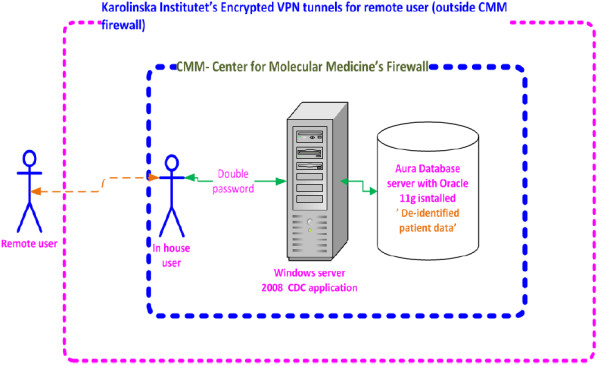
Security layers of the system.